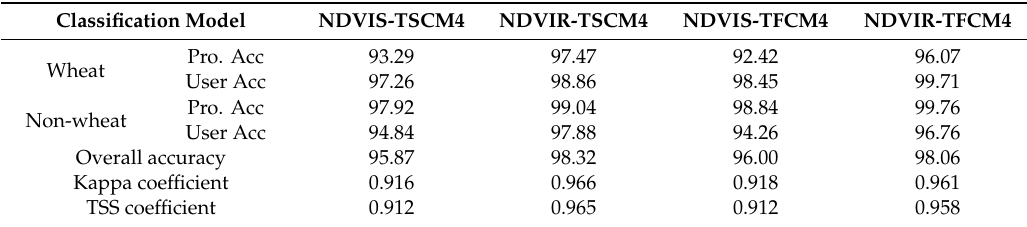
Table 6. Confusion matrix for the classification results using NDVI-TSCM4 and NDVI-TFCM4 under the SVM and RF classifiers